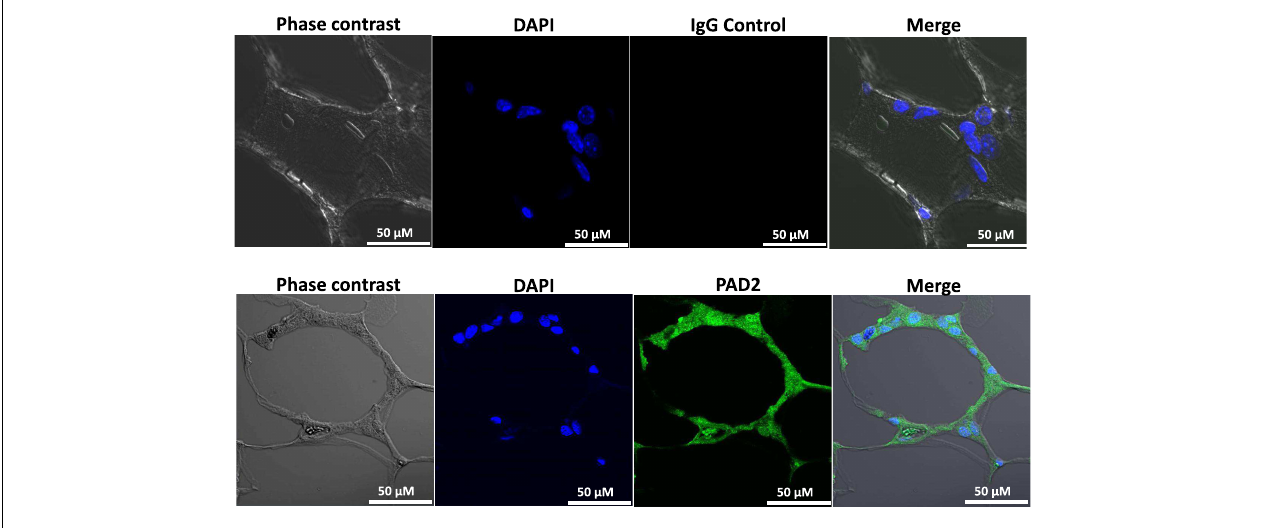
shows that cells within the CLS lesions appear to express PAD2. Nuclei are stained with DAPI. Non-specific rabbit IgG was used as a negative